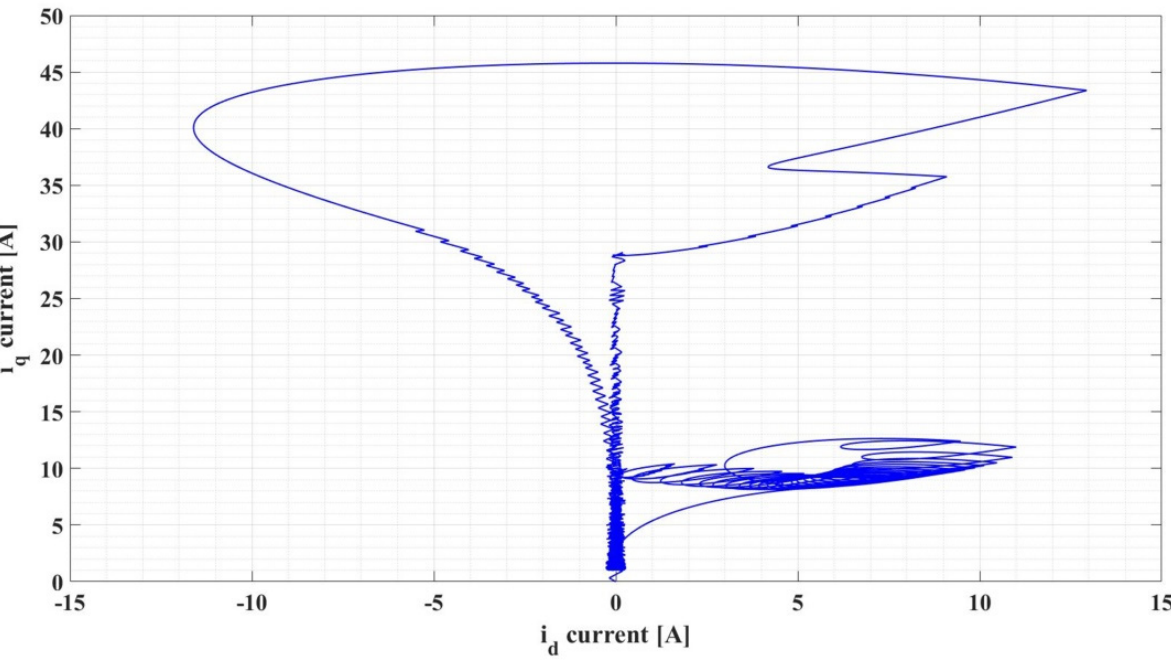
Figure 27. Image of the phase plan for PMSM variable structure with switching signal type 2: i q current versus i d current ( ω ref = [800, 1200] rpm).